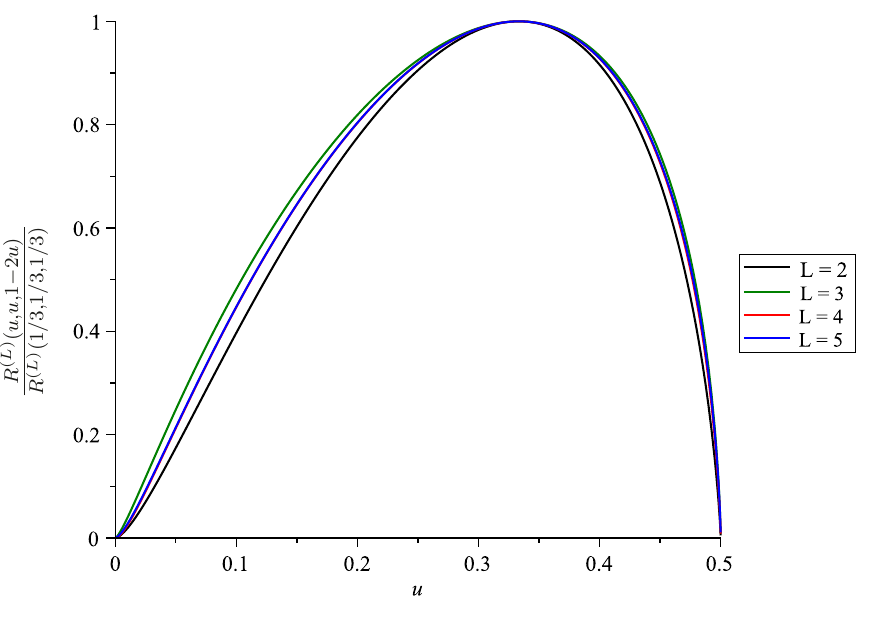
Figure 2. The L -loop form factor remainder function R ( L ) on the Euclidean line ( u, u, 1 − 2 u ) , normalized by its value at u = 1 / 3 . The four-loop curve is hidden under the five-loop one.